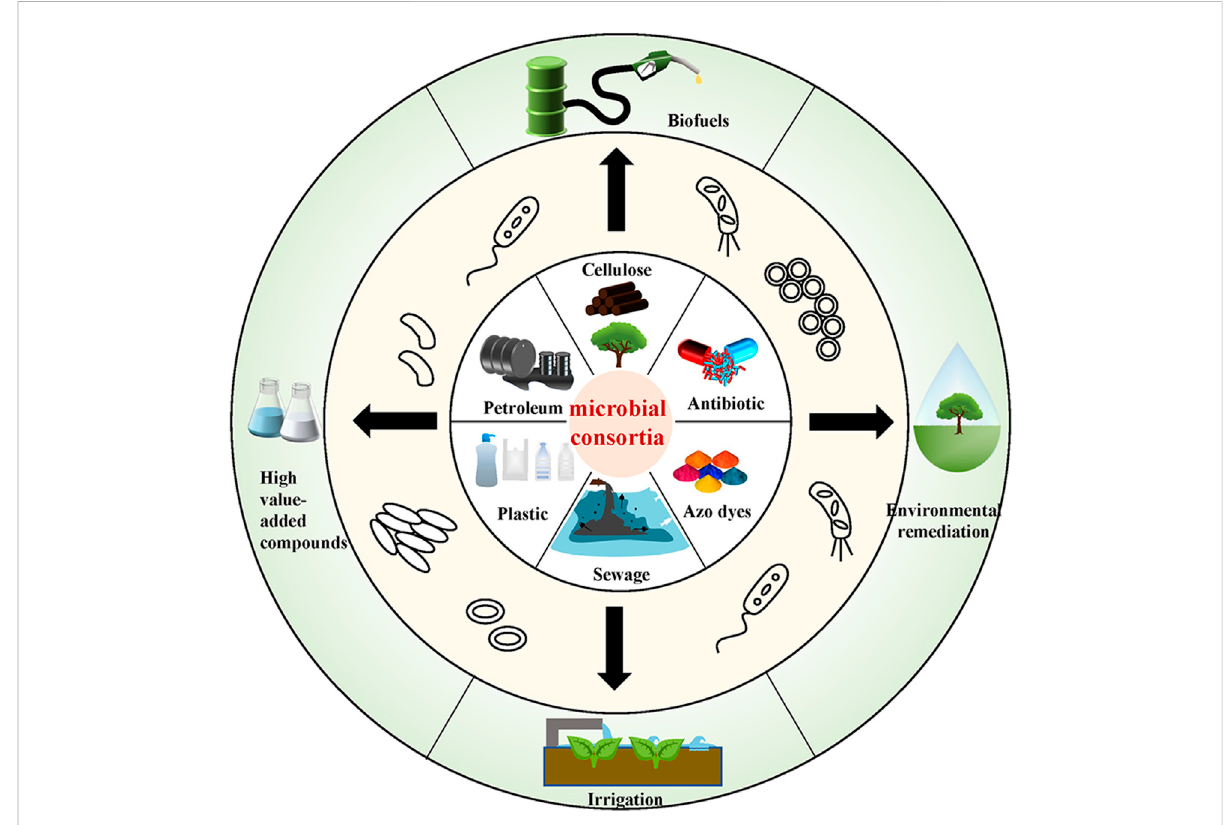
FIGURE 1 Microbial consortia bioremediation and reuse of complex